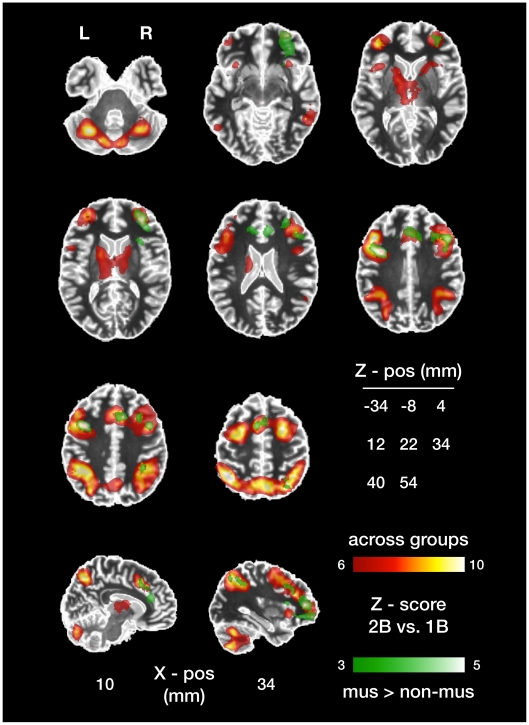
Working memory load-dependent brain responses differ between musicians and non-musicians.Regions in which the BOLD signal is significantly stronger during the 2B than the 1B task condition are shown in red/orange. In addition to this across-groups result, musicians' differential (2B vs. 1B) brain responses were significantly larger than non-musicians' in a subset of these regions shown in green. Both statistical maps are thresholded at Z>3.0 and corrected for multiple comparison at the cluster level (p<.05). The functional imaging results are overlaid on the MNI single-subject brain, which is displayed in the neurological orientation (left is left). The standard MNI space Z-coordinates (in mm) of the 8 axial slices are indicated in the “Z-pos” table.